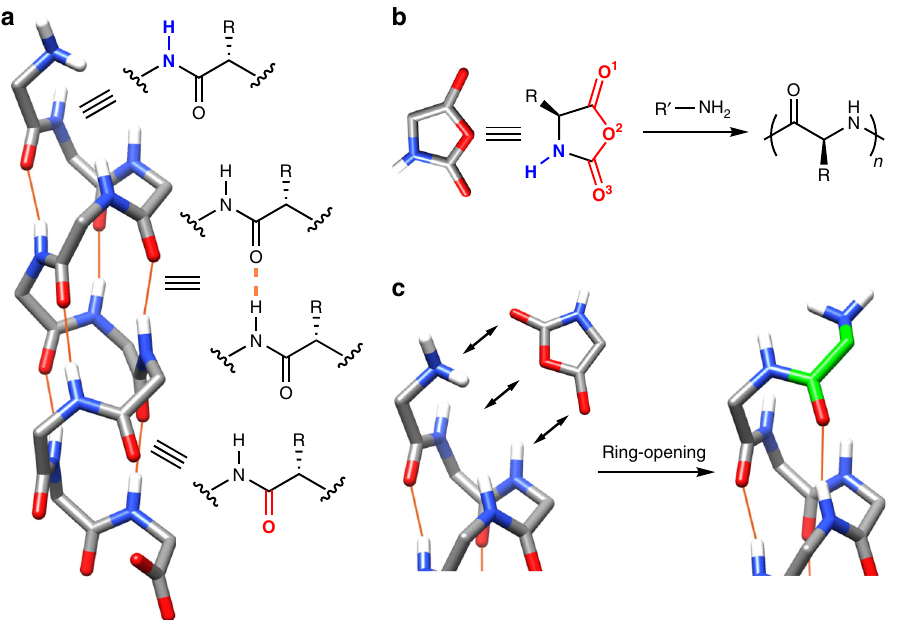
Fig. 1 Schematic illustration of the catalytic power of an α -helix. a Illustration of possible binding sites at the termini of a free α -helical polypeptide. Intrahelical H-bonds are represented with orange lines. Side chains are omitted for simplicity. b Analysis of H-bond acceptors (red) and donors (blue) in an NCA molecule and its polymerization to synthesize polypeptides. c Proposed binding of NCA with the N terminus of an α -helix and subsequent ring- opening reaction for the growth of polypeptide. The newly formed residue from NCA is highlighted in